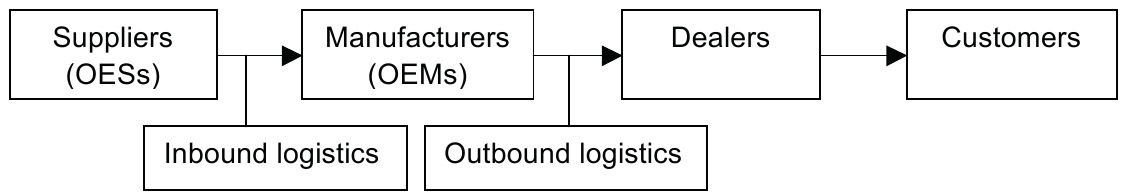
Figure 2: The physical flows of the supply chain